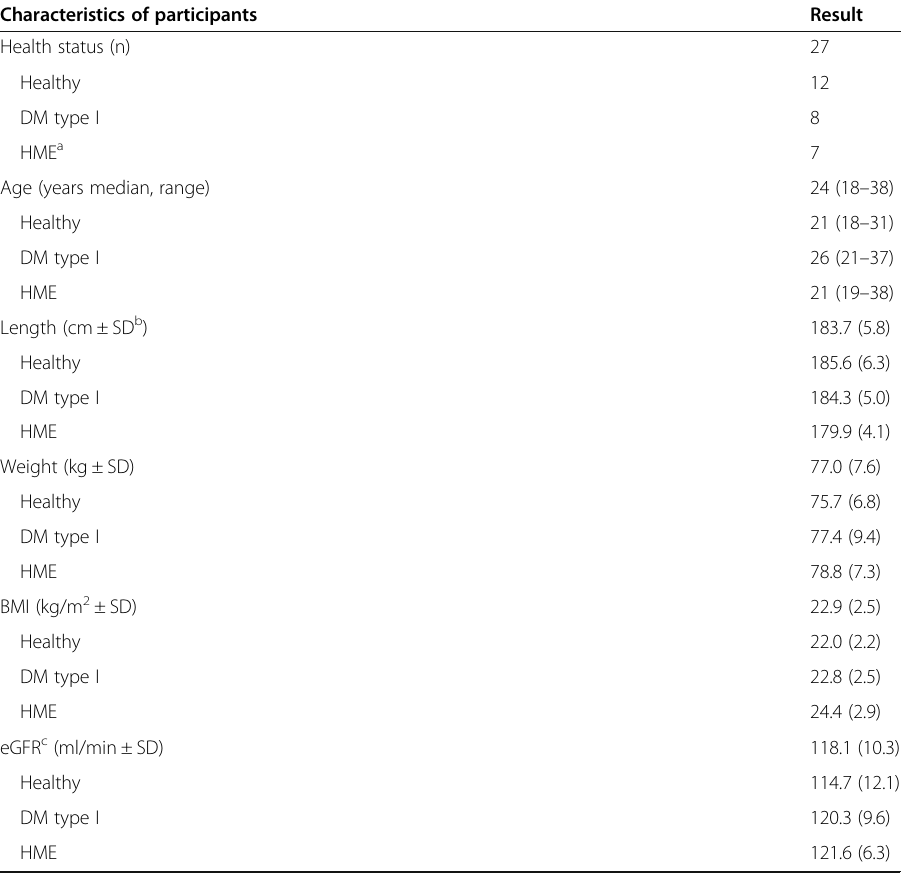
Table 1 Characteristics of study participants